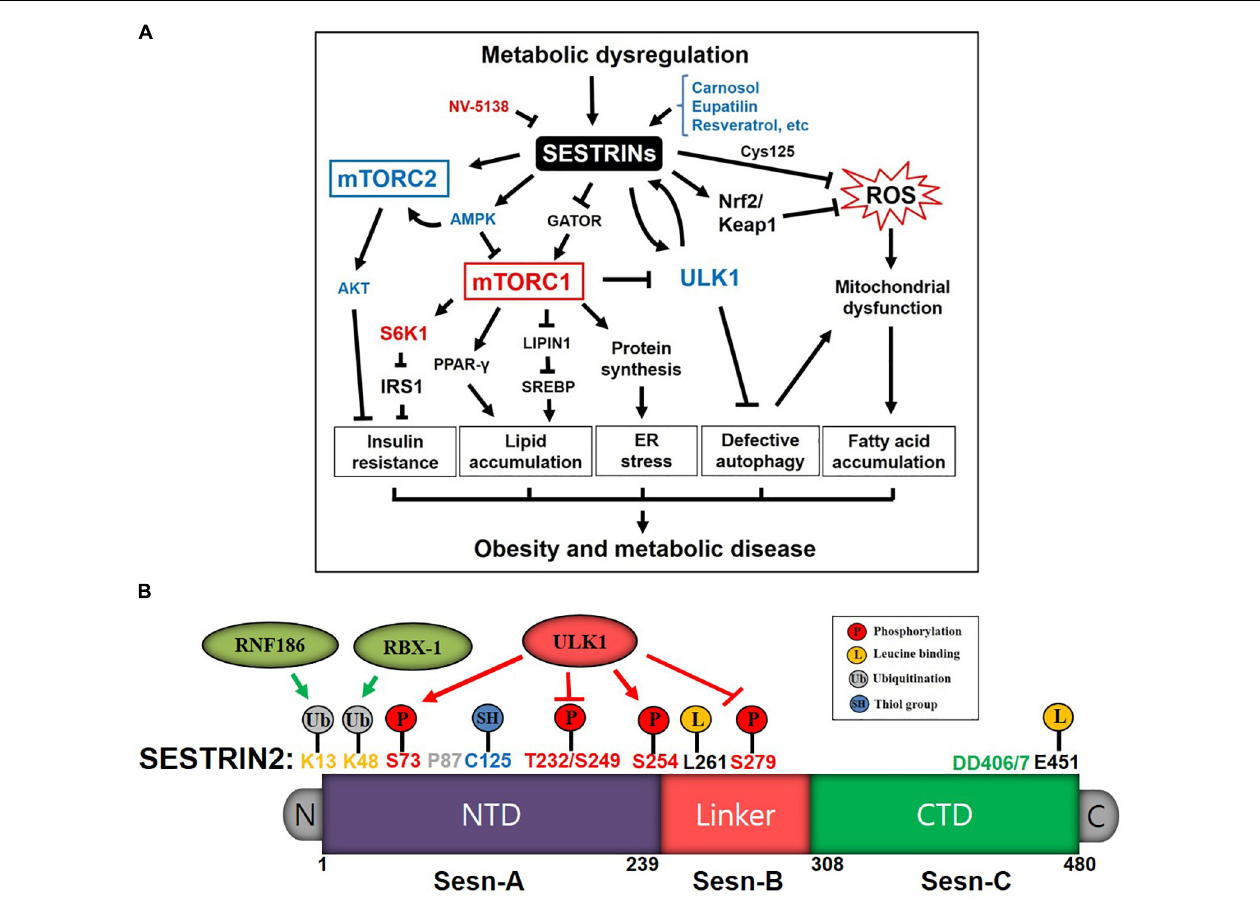
FIGURE 1 | Diagrams depicting the Sestrins-mediated stress signaling pathways and functional domains of Sestrin2 in the regulation of metabolism and disease. (A) Schematic diagram of Sestrins/mTORC/ROS pathways in obesity and metabolic diseases induced by metabolic dysregulation stress. Sestrins improve insulin sensitivity by blocking mTORC1/ribosomal protein S6 kinase 1(S6K1) and activating AMPK and mTORC1/AKT pathway. Sestrins also inhibit lipid accumulation and ER stress via mTORC1 inhibition through activating AMPK and binding GATOR2. Sestrins activate autophagy and mitophagy through mTORC1 inhibition and ULK1 activation, which contributes to reducing ROS and removing dysfunctional mitochondria. ULK1 phosphorylates Sestrin2 to induce mitophagy, and phosphorylated Sestrin2 activates ULK1 to further induce autophagy as positive feedback mechanism. Sestrins protect cells, tissues and organs by alleviating stresses and pathologies associated with obesity and metabolic dysfunctions. (B) Sestrin2 functional domains (Sesn-A, Sesn-B, and Sesn-C domains) and residues for: (i) protein stability and turnover through ubiquitinations by RNF186 and RBX-1; (ii) redox homeostasis through ROS regulation (Cys125); and (iii) nutrient sensing and regulation through leucine binding, ULK1 activation, and autophagy